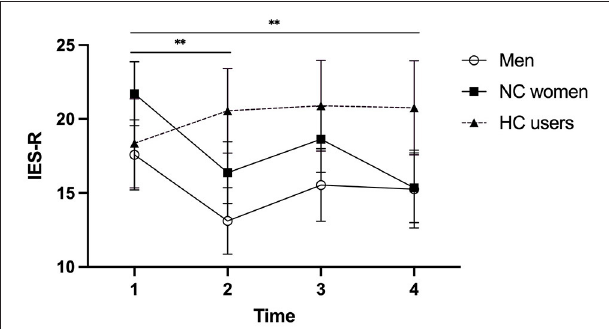
FIGURE 2 | Post-traumatic stress symptoms (measured by the IES-R) of men, naturally cycling (NC) women, and women using hormonal contraceptives (HC) during the COVID-19 pandemic. A significant decrease from T1 to T2 was observed for NC women and men, as well as from T1 to T4 for NC women. Men, NC women, and HC users are illustrated by circles, squares, and triangles, respectively. Error bars represent standard error. ** p <